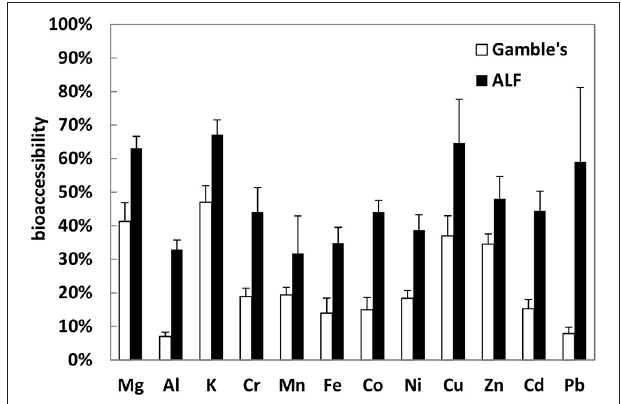
FIGURE 2 | Bioaccessibility of trace elements from TSP in the Gamble’s solution and